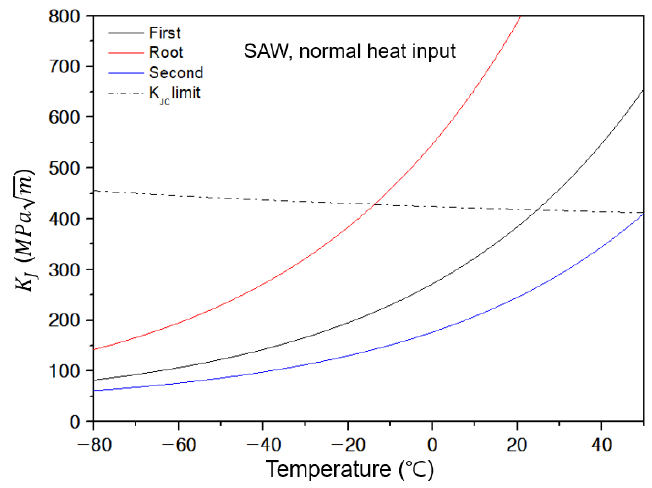
Figure 12. Master curve for SAW, normal heat input condition according to sample location.